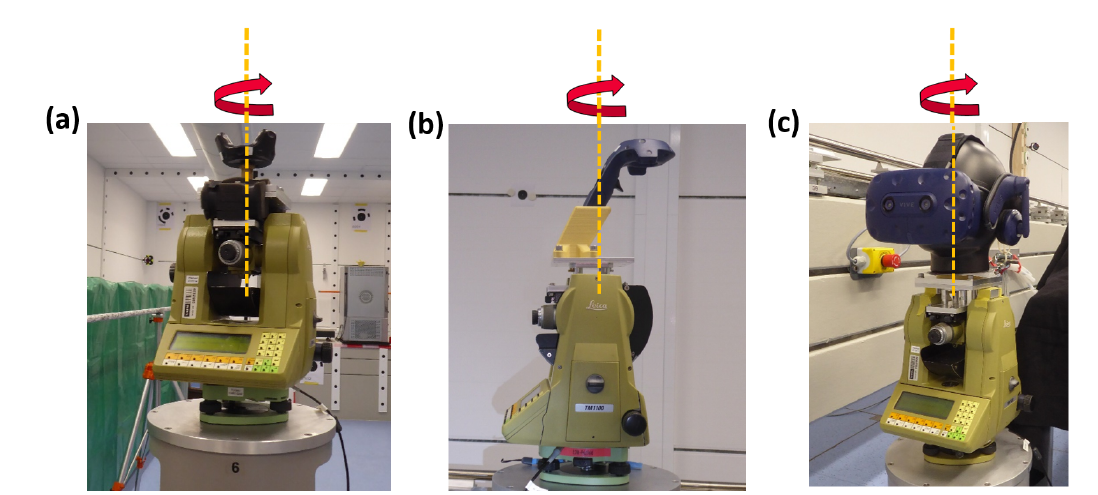
Figure 14. Setup on the TM1100 rotation platform: ( a ) for the tracker, ( b ) for the controllers and ( c ) for the HMD.